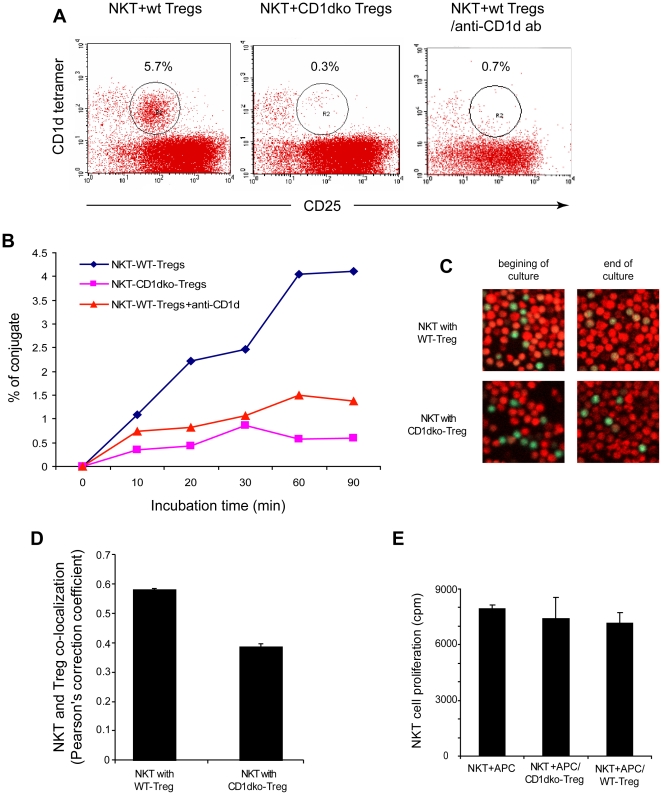
CD1d dependent conjugation of Tregs and NKT cells.Tregs were isolated and co-cultured with either NKT cell hybridomas (A and B) or purified primary NKT cells (C-E). A) Representative dot plots of cells after co-culture for 60 minutes. CD25 represents Treg marker and CD1d tetramer represents NKT cell marker. CD25+ CD1d tetramer+ cells indicated conjugation of Tregs and NKT cells. B) Time course of Treg and NKT cell conjugation after co-culture. C, D) NKT cells and Tregs were labeled with green and red dye, respectively, and co-cultured while their co-localization was measured with confocal microscopy. C) Representative cofocal images showed at the beginning and the end of culture. NKT cells only conjugated with wt Tregs as indicated as yellow colored double labeling. D) Pearson's correlation coefficients were used to determine the conjugation. The coefficient of >0.5 indicated conjugation and <0.5 indicated no conjugation. E) NKT cell proliferation assays similar to those described in Fig. 2C except the Tregs were placed in transwells. NKT:Treg = 1∶1, (B – E, n = 3/exp, and the experiments were repeated three times).